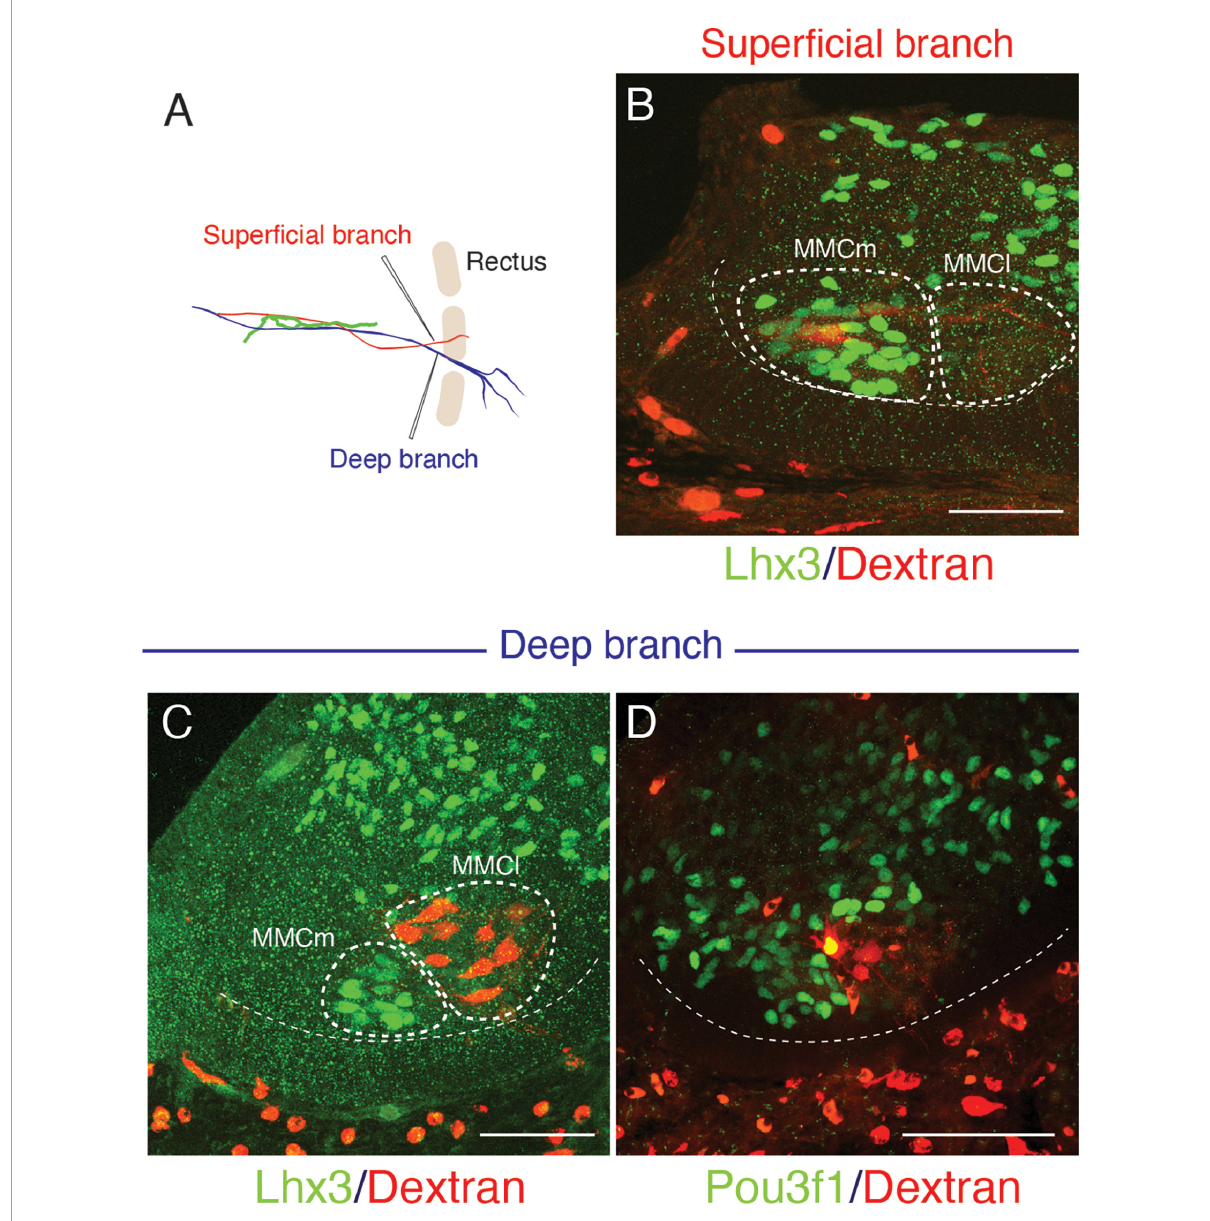
FIGURE3 Differential origins of the superficial and deep branches of the intercostal nerves. All micrographs are transverse sections of the lower thoracic spinal cord from E13 embryos. The margins of the ventral horns are in thin dashed lines. The midline of the spinal cord is toward the left side, and the dorsal side is toward the upside of the micrographs. The thick dashed lines encircle the medial (MMCm), and lateral (MMCl) halves of the medial motor columns. (A) The injection points are in the superficial (red) and deep (blue) branches, which are close to the rectus muscle band (light brown). (B) The labeling (red) is in the Lhx3-positive (green nuclei) motor neurons, which are in the MMCm, but not in the MMCl following the injection into the superficial branches. (C,D) Following injection into the deep branches, labeling is restricted within the MMCl, where Lhx3 expression is negative, and the Pou3f1-positive nuclei (green) with a high expression level are observed in the labeled motor neurons (red) in the